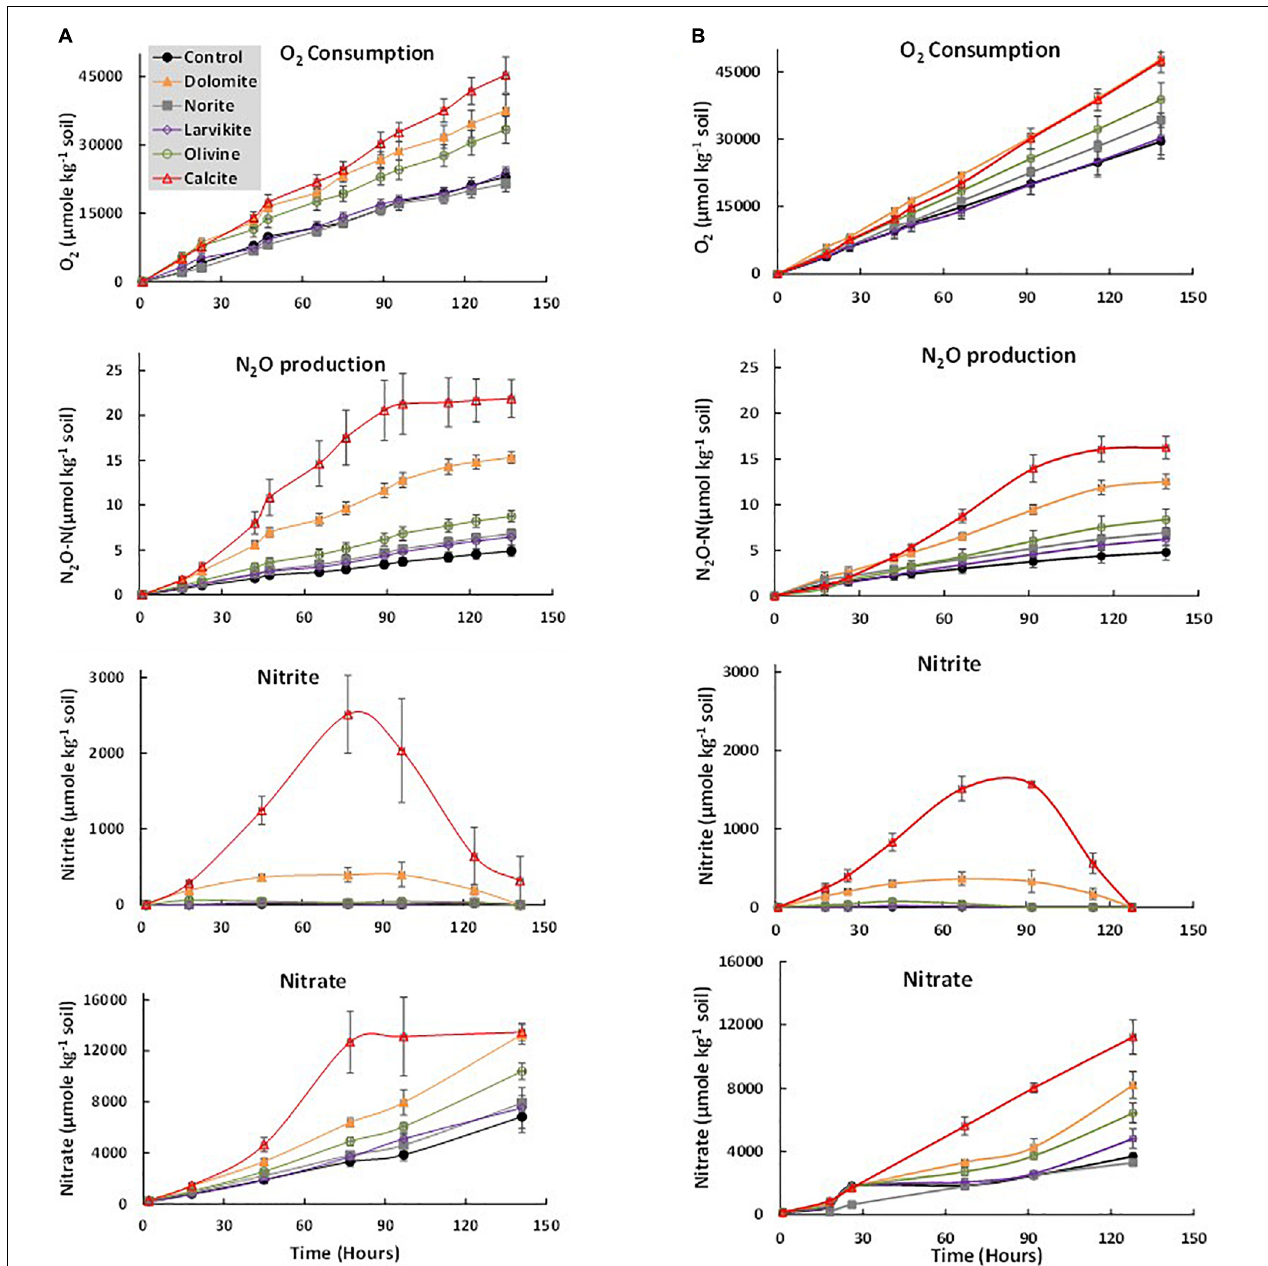
FIGURE 2 | Nitrification in oxic soil slurries. Oxygen consumption (cumulative), and production of N 2 O nitrite and nitrate oxic soil slurries. Plotted values are the means and standard errors of four field replicates of each mineral treatment. Plotted gas kinetics are from two incubations experiments with soil collected from the field December 2015 (Panel A ) and 2016 (Panel B ) (15 and 27 months after application of minerals).